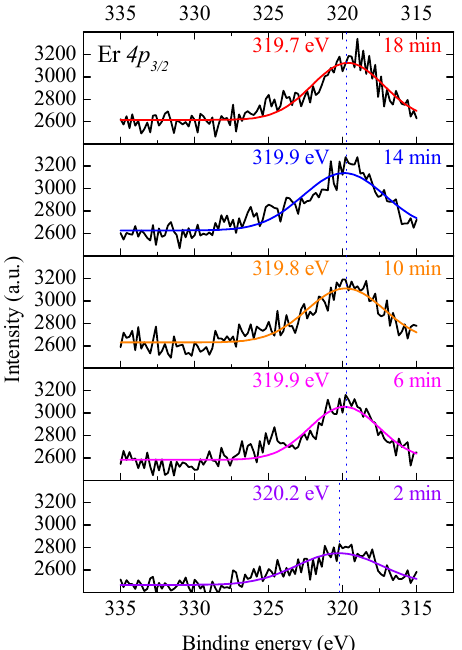
Figure 3. Photoelectron spectra of Er 4p 3/2 core level for a typical AlN:Er sample deposited at 400 °C after various length of time Ar + milling.